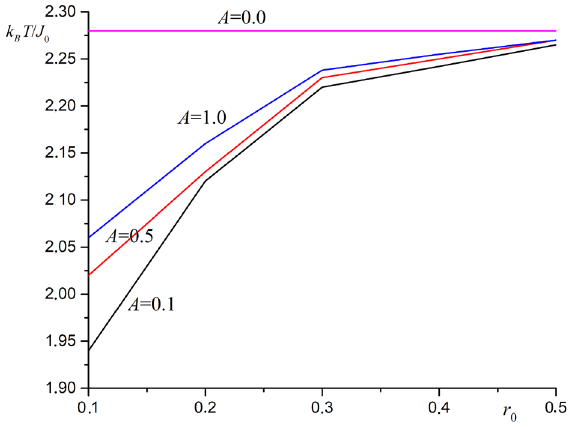
Figure 2. The graph for phase transition temperature versus parameter r 0 for substrate compression case ( b = 0.95 a 0 ) at different values of substrate potential amplitude.